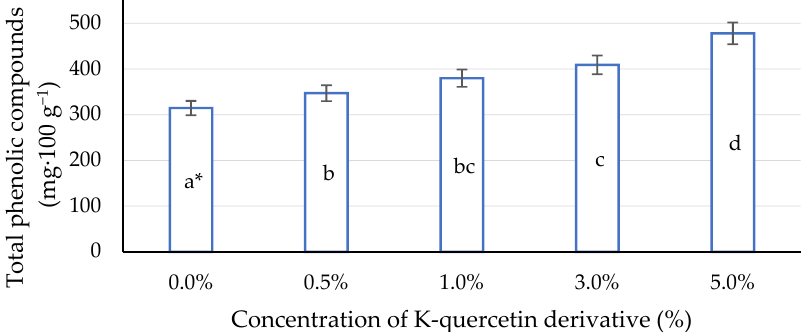
Figure 7. Impact of different aqueous concentrations of potassium quercetin derivative on total phenolic compounds in maize leaves. * Lower case letters indicate significant differences between concentrations of K-quercetin derivatives ( p < 0.05).